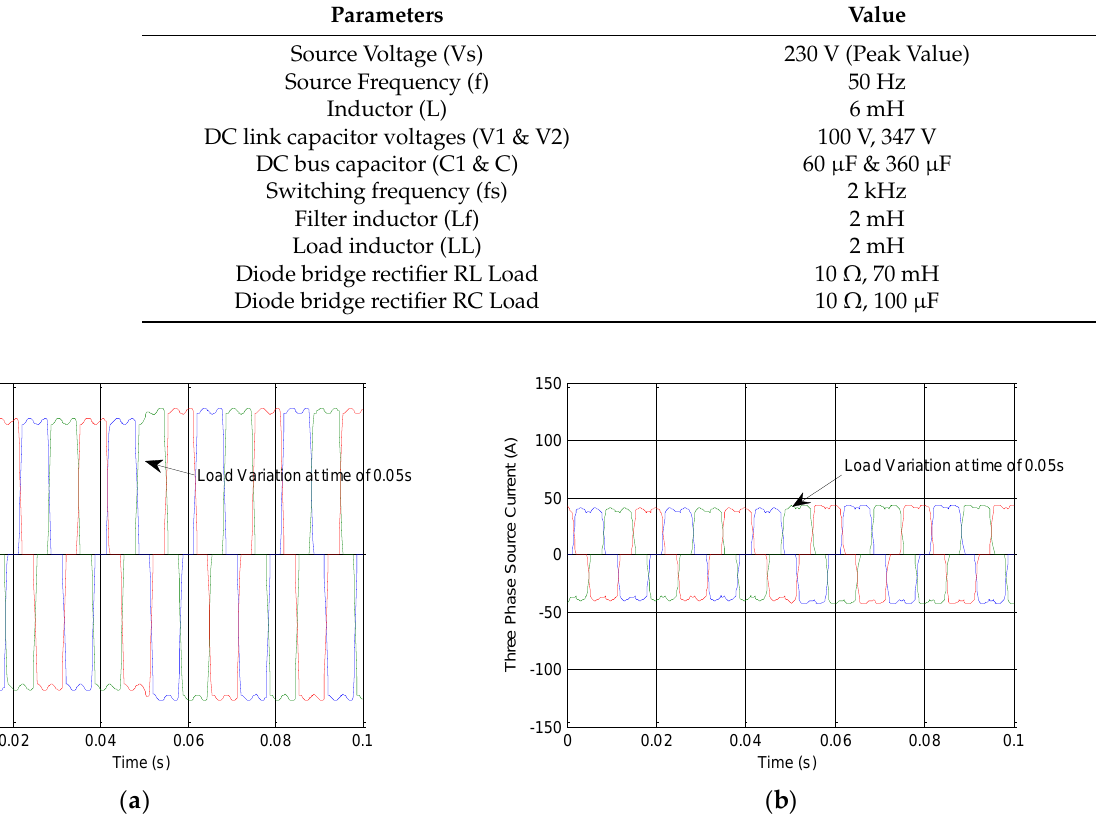
Figure 7. Simulated responses of the source current in the power system without SAPF for ( a ) RL load and ( b ) RC load.